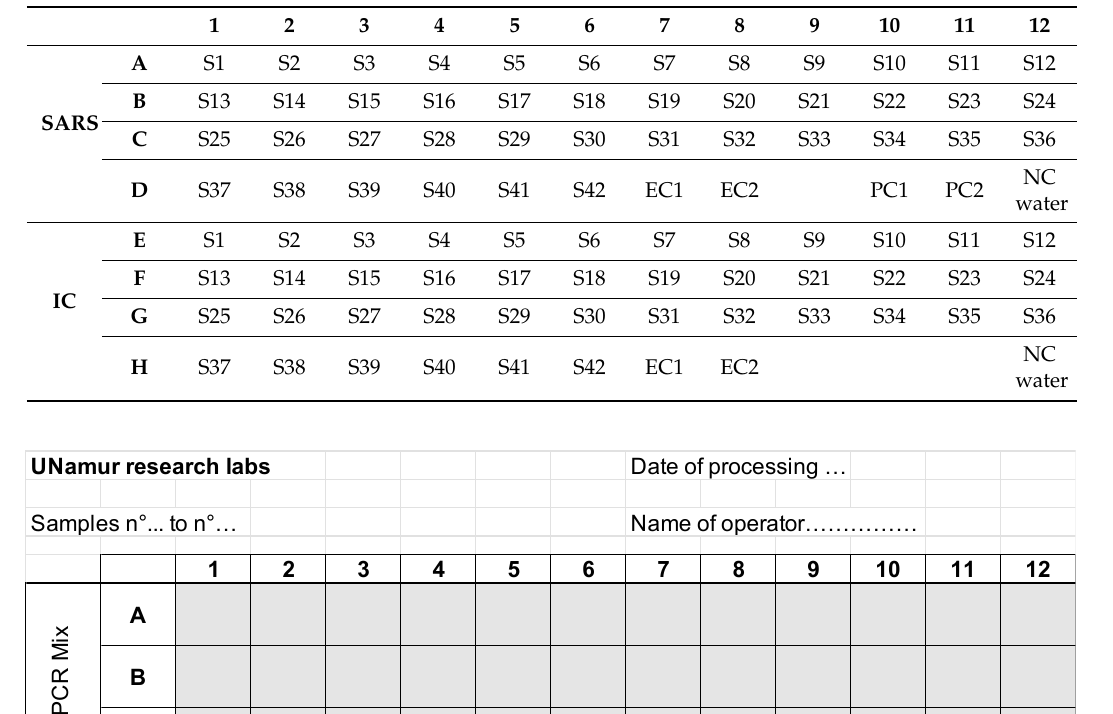
Table 2. Disposition of Samples on the PCR plate.